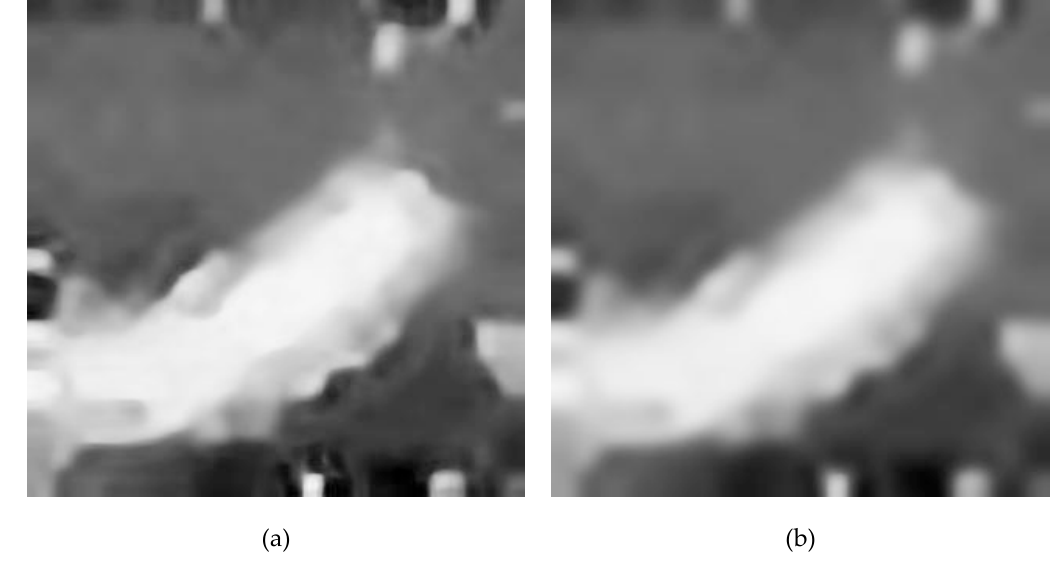
Figure 10. ( a ) The image to be processed. ( b ) After adaptive guided filtering.